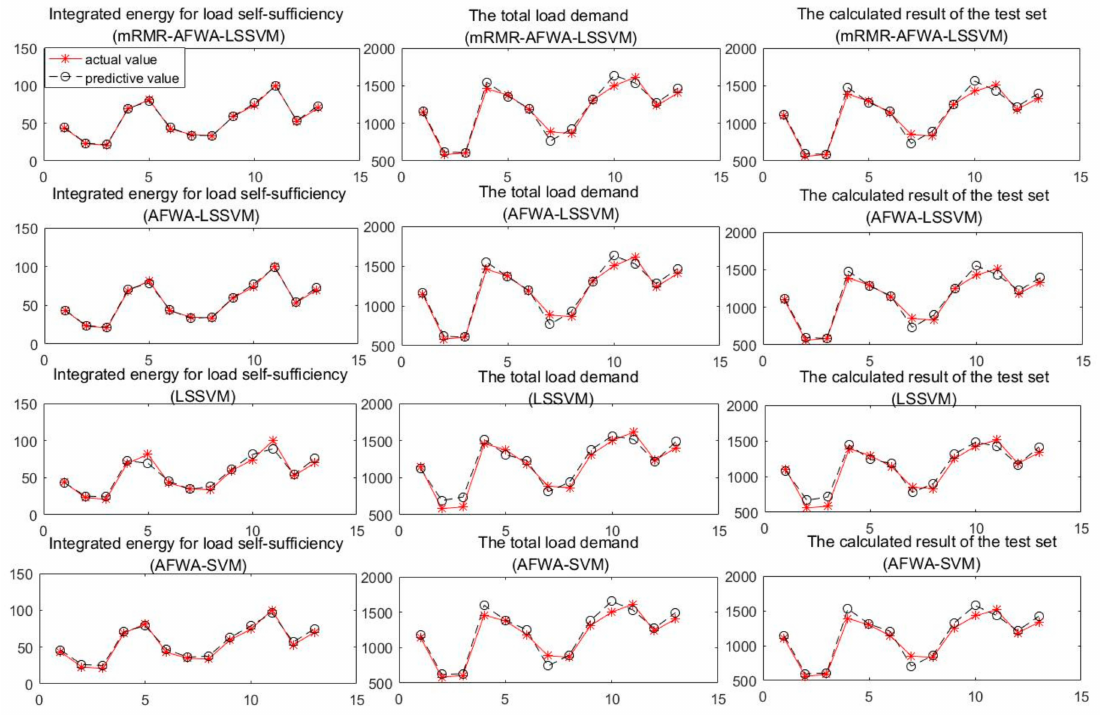
Figure 9. Forecasting results of four